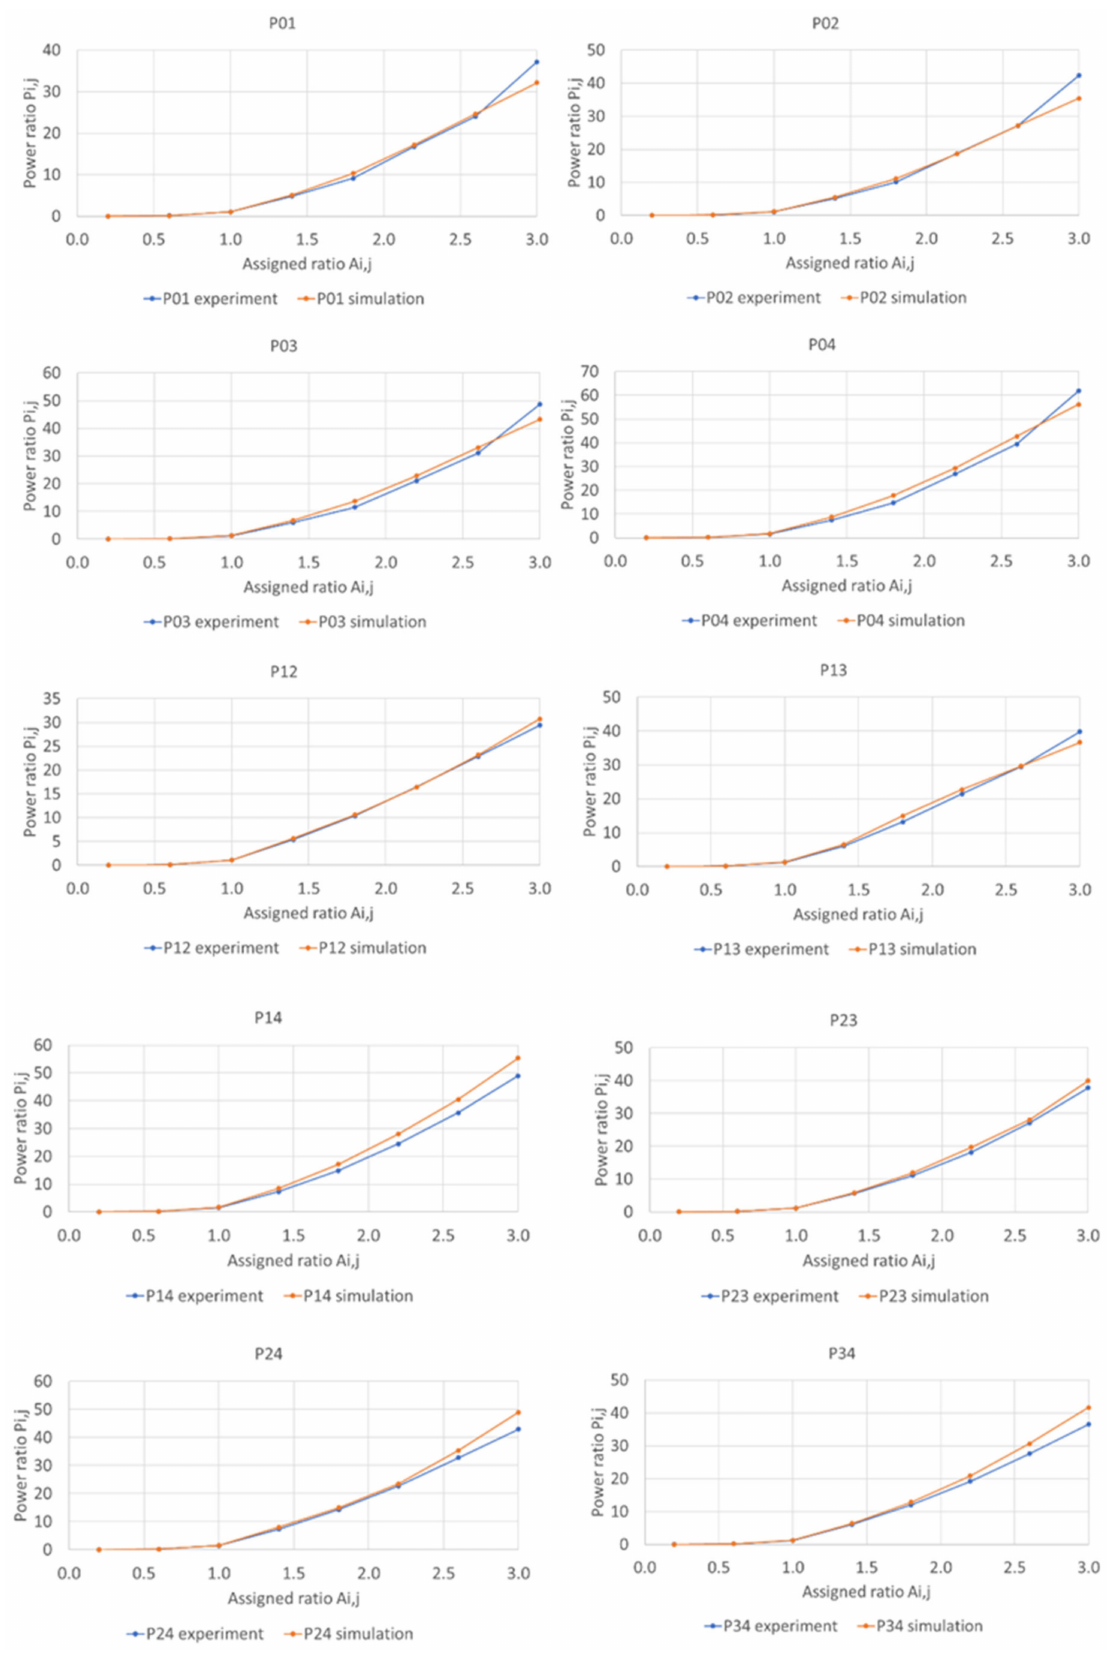
Figure 12. The comparison between power ratio measurement results ( blue ) and simulated power ratio results ( orange ) case by case from P 0,1 to P 3,4